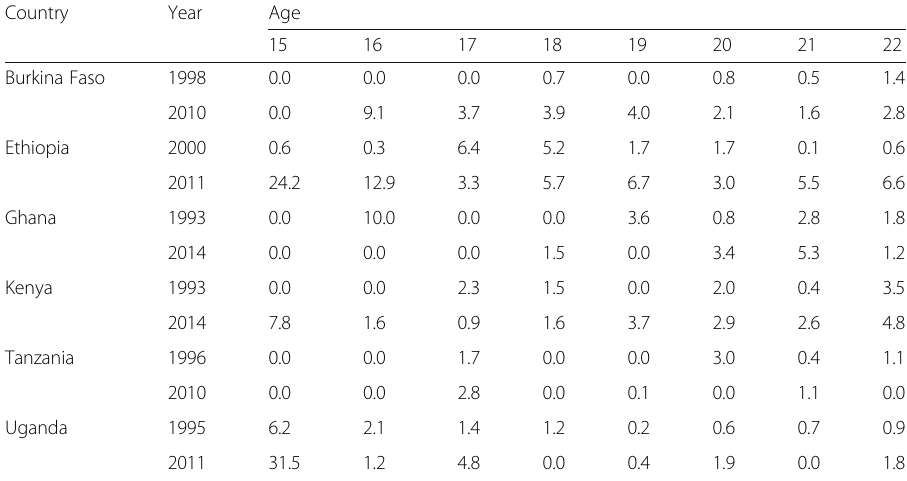
Table 3 percentage of married young women in education, by age Country Year Age Burkina Faso 1998 Ethiopia 2000 Ghana 1993 Kenya 1993 Tanzania